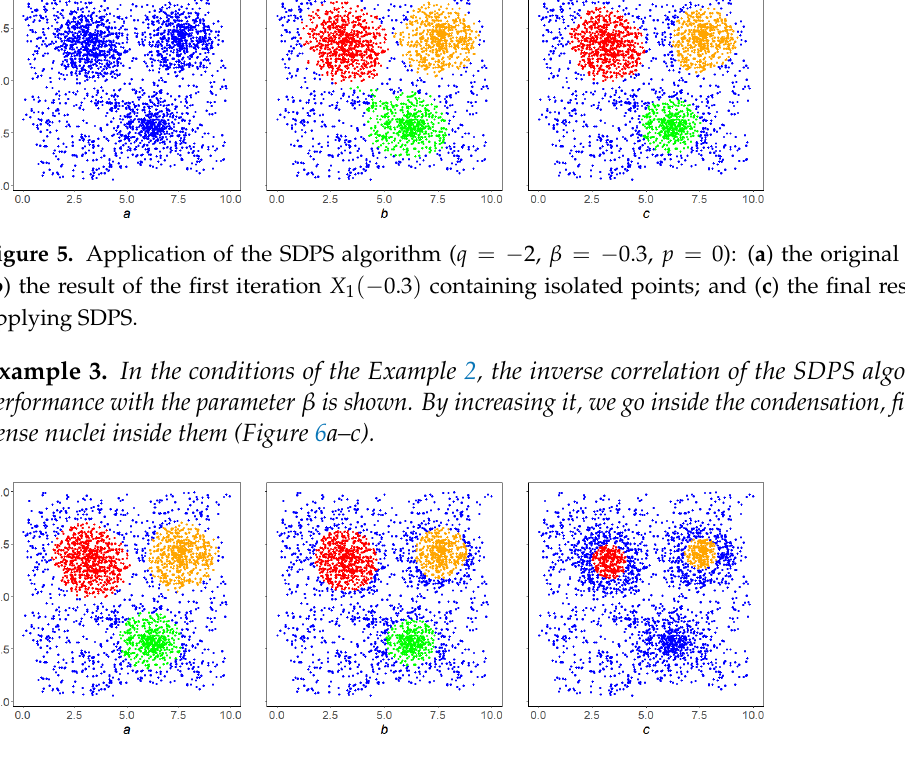
Figure 6. Inverse dependence of the result of the SDPS algorithm on the parameter β : ( a ) the result of the SDPS algorithm at β = − 0.35; ( b ) the result of work at β = − 0.15; and ( c ) the result of work at β = 0.05. (In all cases q = − 2, p =